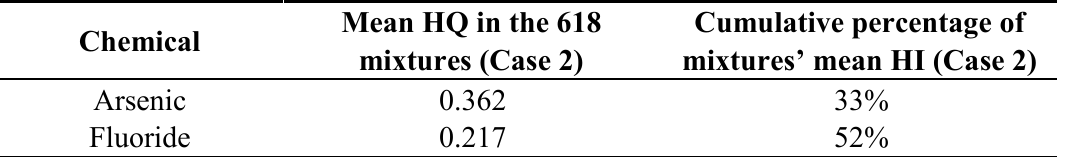
Table 5. Chemicals with the highest average hazard quotient (HQ) in the 618 mixtures and their cumulative contributions to the mean HI of the